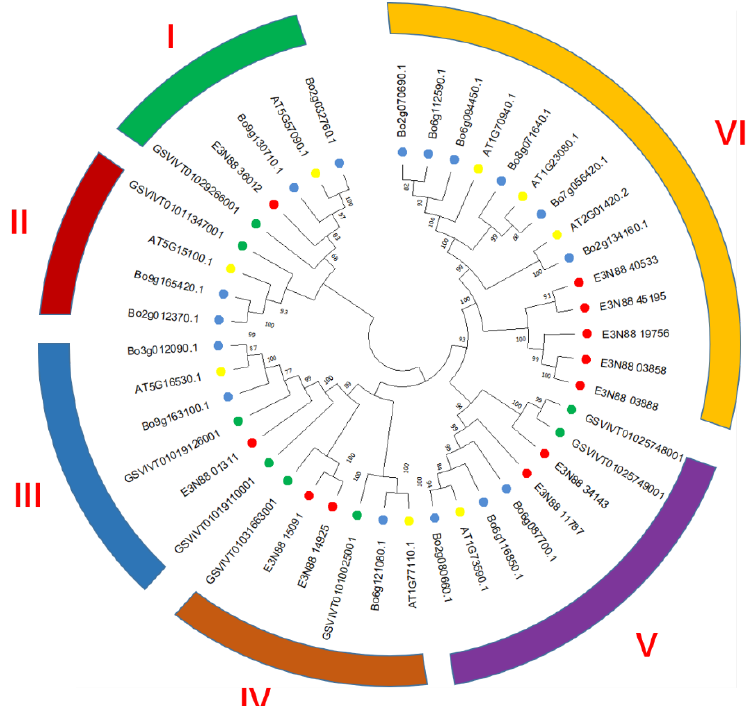
Figure 1. Phylogenetic analysis of PIN auxin transporter in M. micrantha , A. thaliana , B. oleracea and V. vinifera . The 43 PIN proteins from four plant species could be classified into six distinct clades (group I–VI) and differentiated in color. M. micrantha , A. thaliana , B. oleracea and V. vinifera are distinguished by solid circle shapes in red, yellow, blue and green,